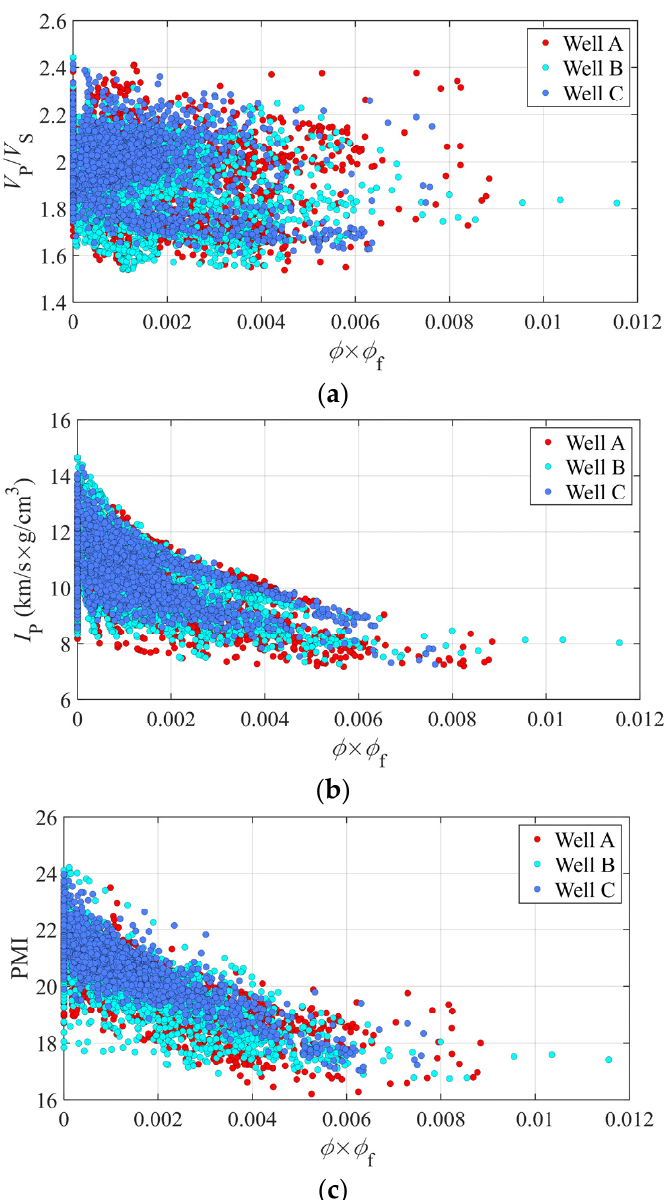
◦ for wells A, B, and C.